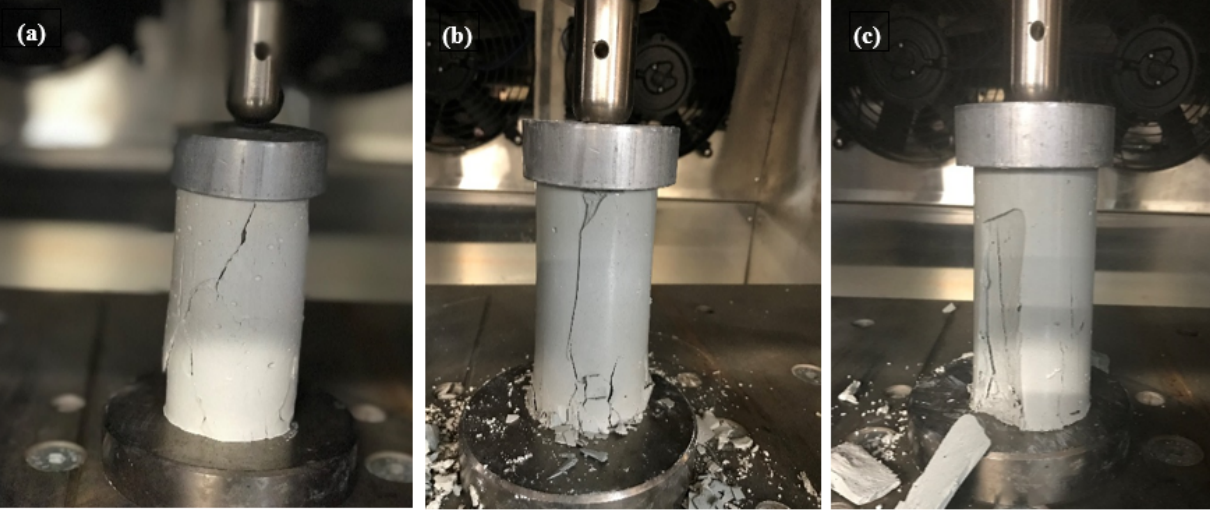
Figure 8. Typical influence of geopolymer addition on UCS failure mode of treated clay: ( a ) 10% geopolymer; ( b ) 20% geopolymer; and ( c ) 30% geopolymer.